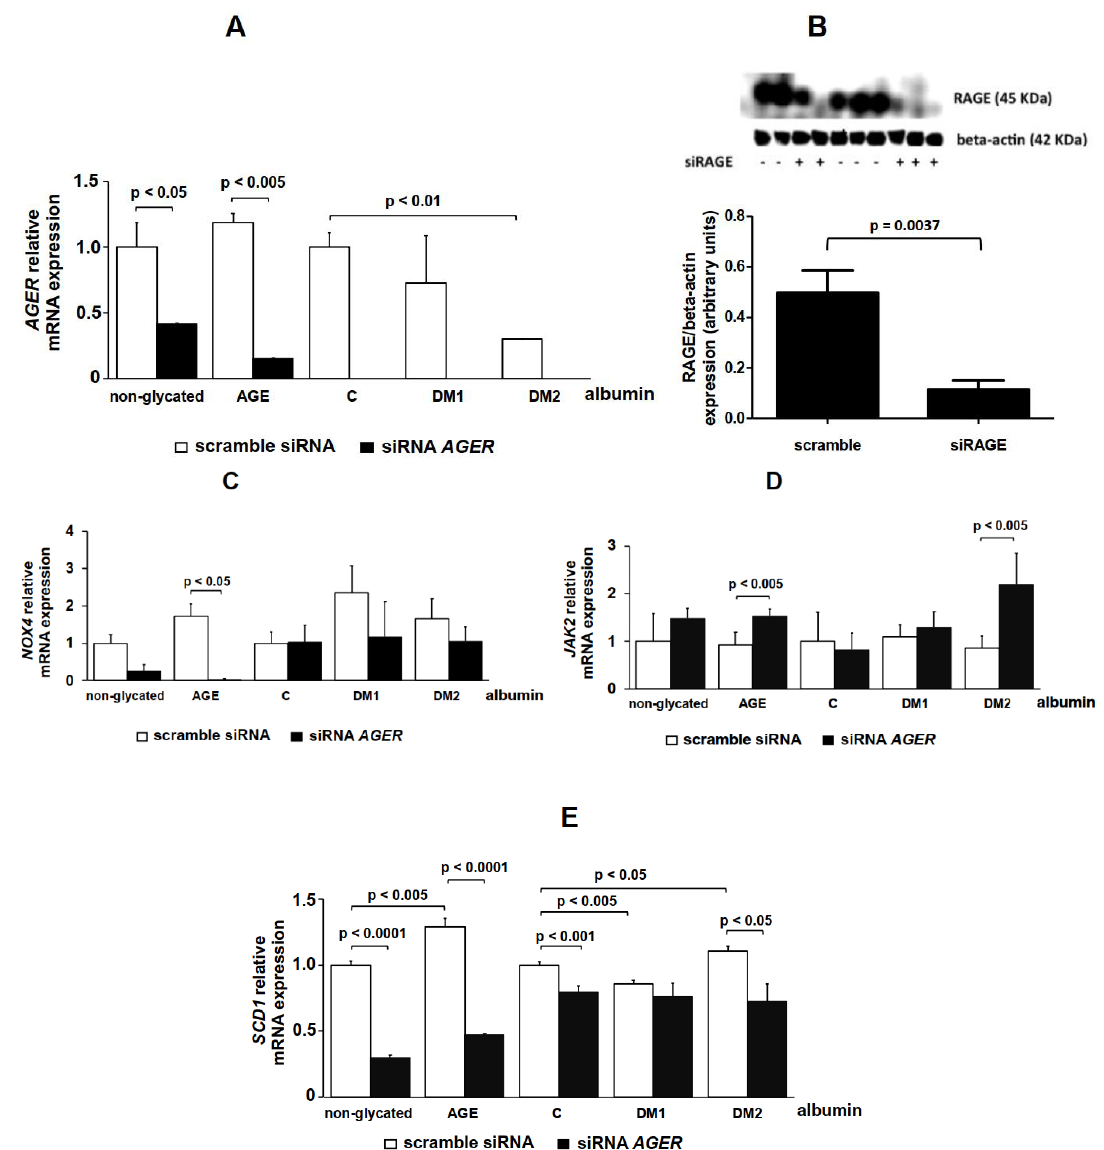
Figure 4. Gene expression in THP-1 cells transfected with scramble siRNA and siRNA- AGER. THP-1 cells ( n = 4) were transfected with small interfering RNA (siRNA) duplexes against AGER (AM16706, Ambion, Austin, TX, USA). Separated wells of THP-1 cells were electroporated with a scramble siRNA (AM4635, Ambion) as a negative control. After 96 h, cells were maintained for 48 h in DMEM containing 1 mg / mL of non-glycated, AGE, control, DM or DM 2 albumin. RT qPCR was performed for ( A ) AGER , ( C ) NOX4 , ( D ) JAK2 and ( E ) SCD1 using TaqMan Universal PCR Master Mix (Applied Biosystems). IPO8 rRNA (Applied Biosystems) was used as an endogenous reference gene. Protein levels of RAGE by Western blotting ( B ). One-way ANOVA—Dunnett’s posttest; mean ±